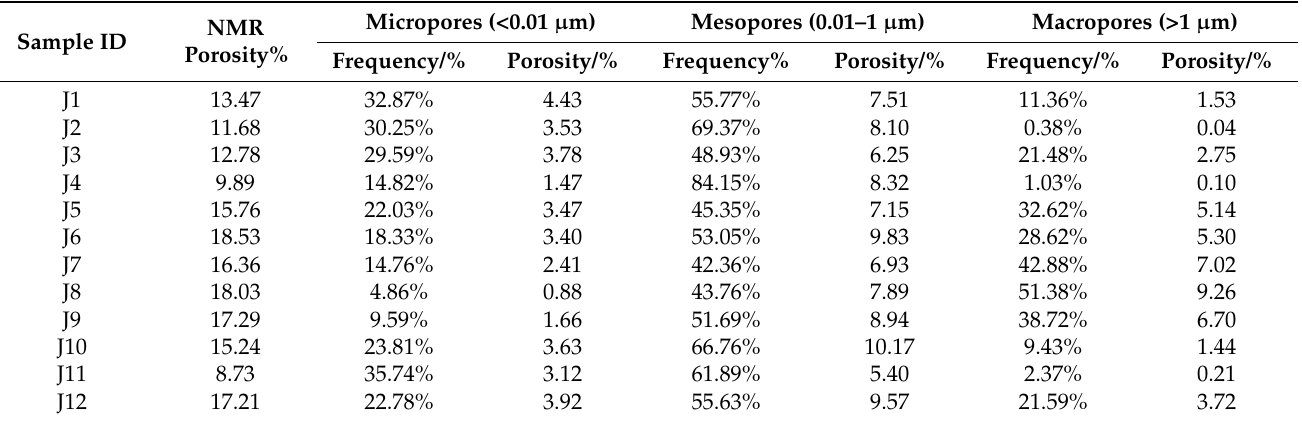
Table 8. Contribution of pore size at different scales to porosity and